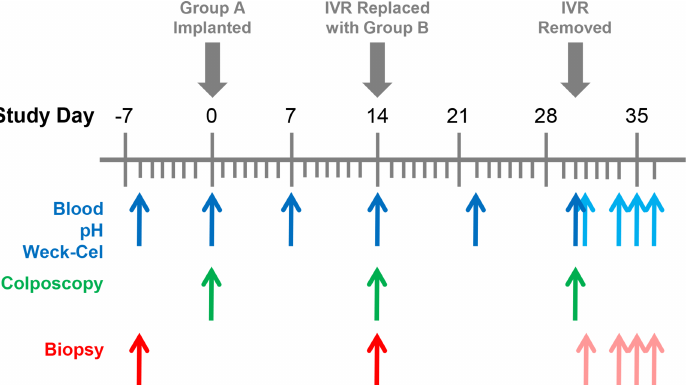
Fig 1. Pigtailed macaque TAF2-ACV-ENG-EE pod-IVR study timelines and biological sample collection points ( N = 6). Configuration A pod-IVRs (rapid-releasing ENG) were inserted on Day 0 and replaced on Day 14 with Configuration B pod-IVRs (slow-releasing ENG). The Configuration B IVRs were removedon Day 30 and animalswere euthanized on Day 34 (animalID BB495 and DC42), Day 35 (animal ID PHz1 and PPk2), and Day 36 (animal ID PEc2 and BB0539). Blue arrows, in order of collection,blood,pH, and vaginalfluid (two Weck-Cel samples per time point—twoproximal and two distal to the IVR). Green arrows, colposcopyexamination (right after blood collection).Red arrows, vaginaltissues (six pinch biopsies per time point—threeproximaland three distal to the IVR). Completevaginaltracks were collectedat necropsy. Pale blue and pale red arrows correspond to sample collectionpoints with the IVR